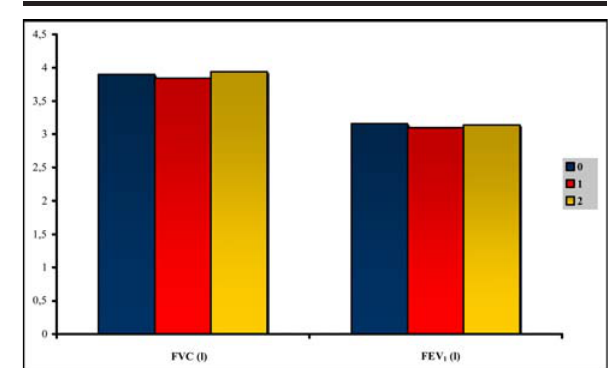
FIGURE 5 - Diagram representing the means of variables FEV1 at evaluations 0, 1 and 2